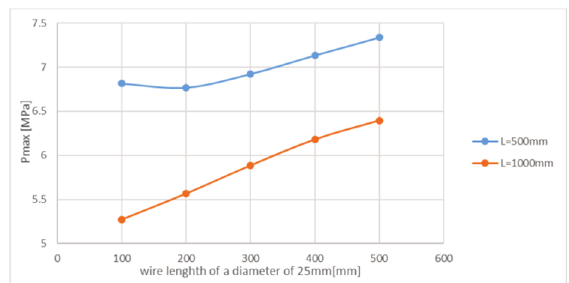
Fig. 7. Pressure changes in the indicator channel with a diameter of 25 mm in relation to the distance from the combustion chamber